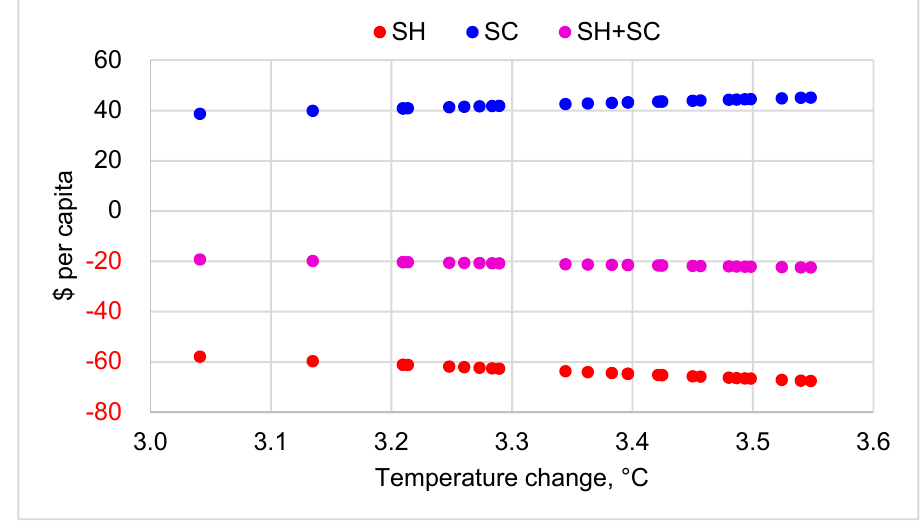
Figure 6. Residential per capita space heating and space cooling expenditure change versus temperature change at 3 ◦ C GMST increase, for the 27 states and state